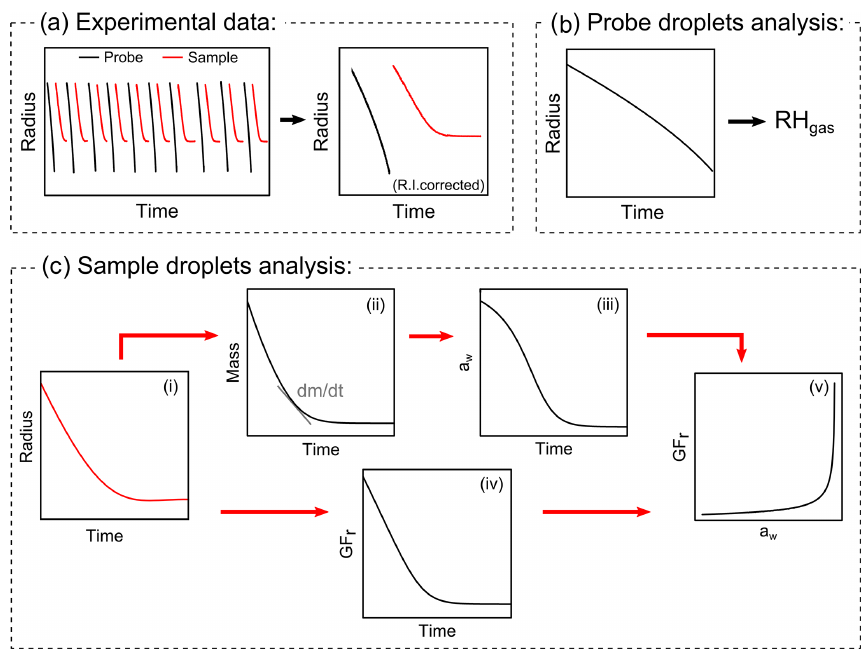
Figure 1. Schematics representing the retrieval of hygroscopic growth curves from comparative kinetics experiments in a CK-EDB. An experimental sequence of alternating single evaporating probe and sample droplets is collected (a) . For each pair of probe and sample droplets, the gas phase RH is inferred from the evaporation kinetics of the probe (b) and this information is used to analyse the corresponding sample droplet hygroscopic properties as indicated in (c)